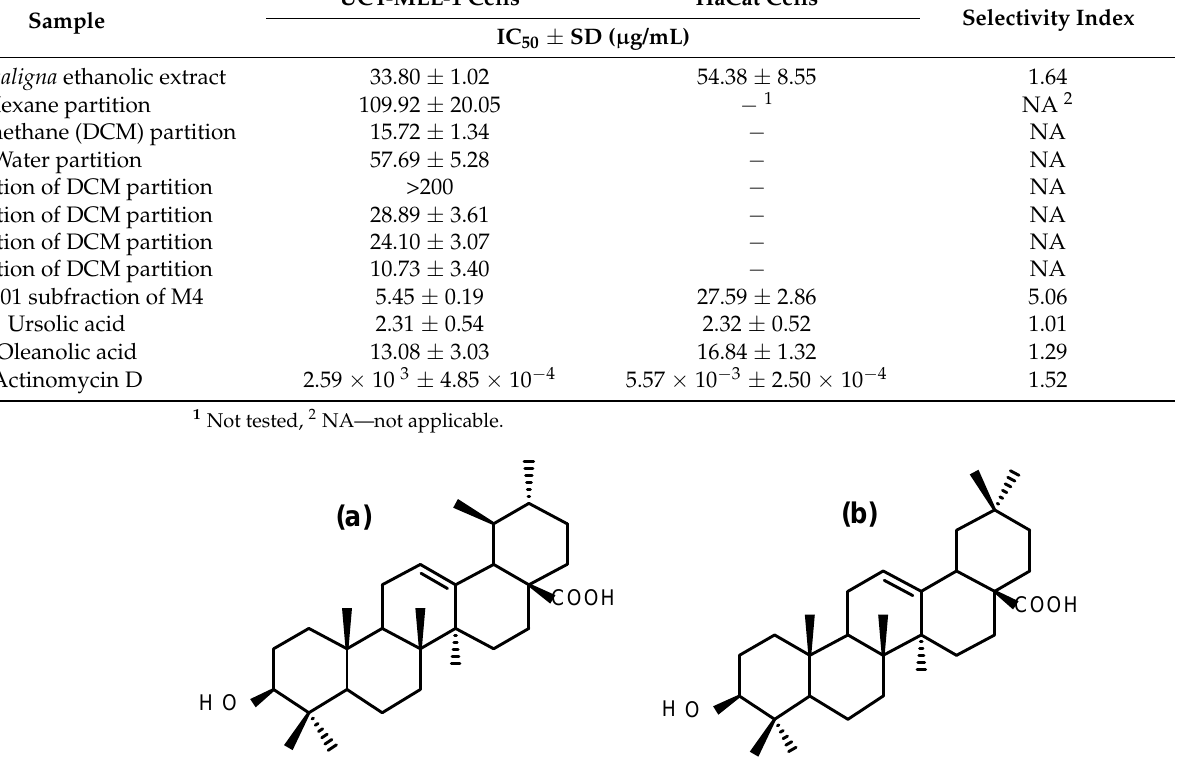
Figure 1. Chemical structures of ( a ) ursolic acid and ( b ) oleanolic acid. The antiproliferative activity of OA and UA was evaluated against UCT − MEL − 1 and HaCat cells, with UA exhibiting an IC 50 value of 2.31 ± 0.54 µg/mL (5.06 µM) and 2.32 ± 0.52 µg/mL (5.10 µM), respectively (SI: 1.01), and OA showed an IC 50 value of 13.08 ± 3.03 µg/mL (28.64 µM) and 16.84 ± 1.32 µg/mL (36.87 µM), respectively (SI: 1.29). These findings showed that DT − BS − 01 has a higher selectivity towards UCT − MEL − 1 cells compared to non-tumorigenic keratinocytes. Moreover,